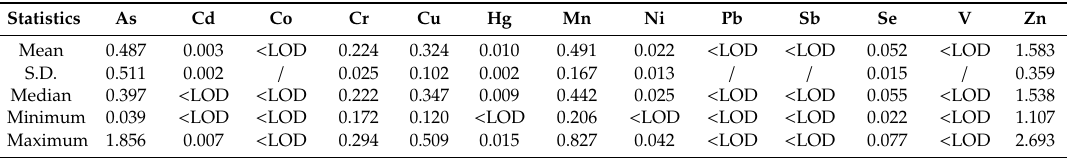
Table 2. Descriptive statistics of metal / metalloid levels (mg / Kg w . w .